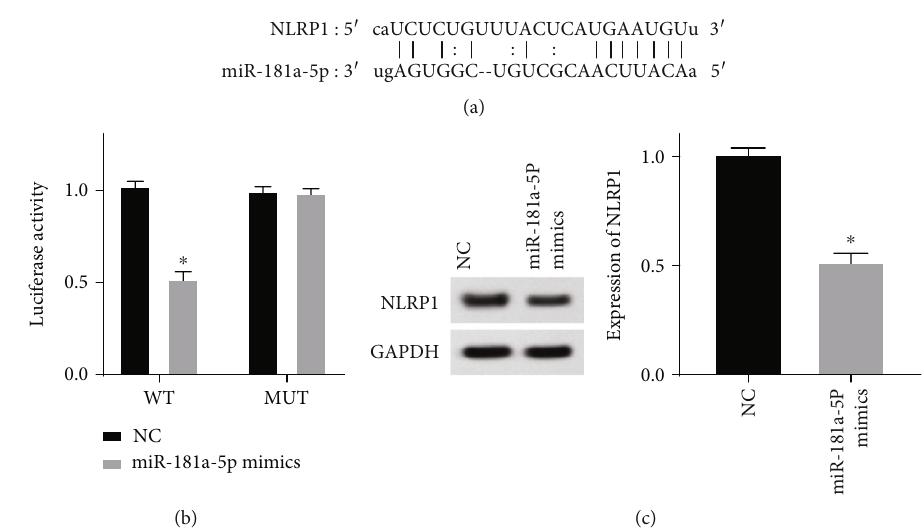
Figure 4: Relationship between miR-181a-5p and NLRP1. (a) Binding sites between miR-181a-5p and NLRP1 predicted by StarBase. (b) The interaction of miR-181a-5p and NLRP1 determined by dual-luciferase reporter assay. (c) NLRP1 expression level measured by western blotting. ∗ P < 0 : 01 vs. NC